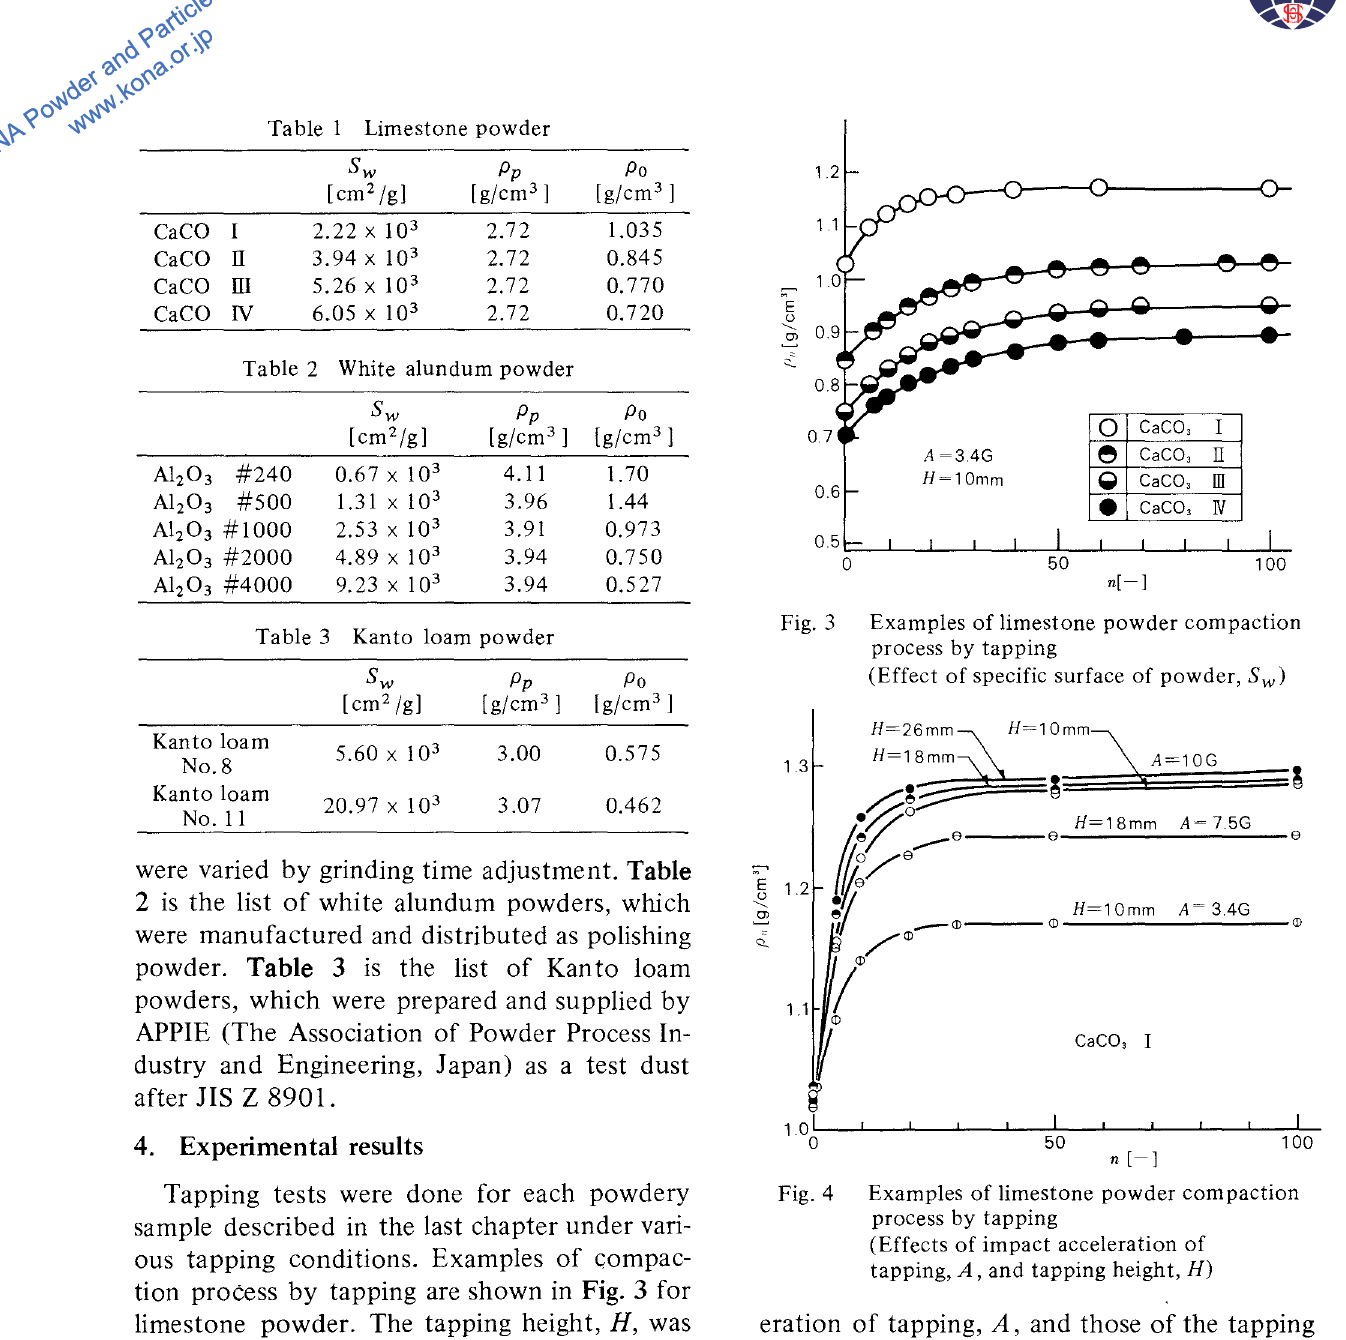
Examples of limestone powder compaction process by tapping (Effects of impact acceleration of tapping, A, and tapping height,